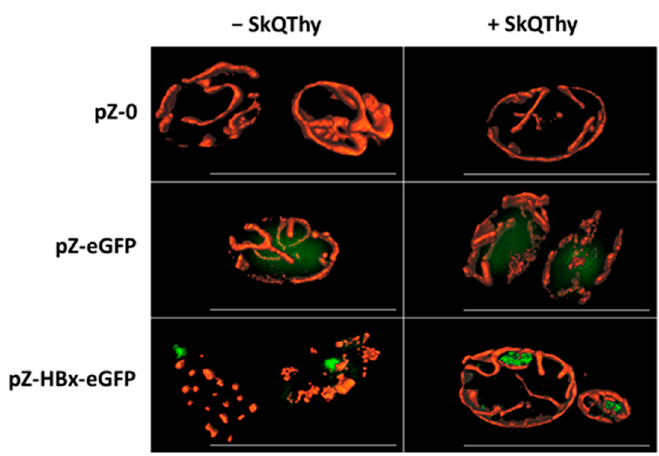
Figure 2. Mitochondrial morphology of Y. lipolytica mutants. Effect of SkQThy. eGFP fluorescence shown in green. Bars are 10 μ m. Cells were preincubated without SkQThy ( left panel) or with 250 nM SkQThy ( right panel) for 1 h, then washed with 50 mM PBS, pH 5.5, and stained with 500 nM MitoTracker Red CmxRos (shown in red) for 30 min.